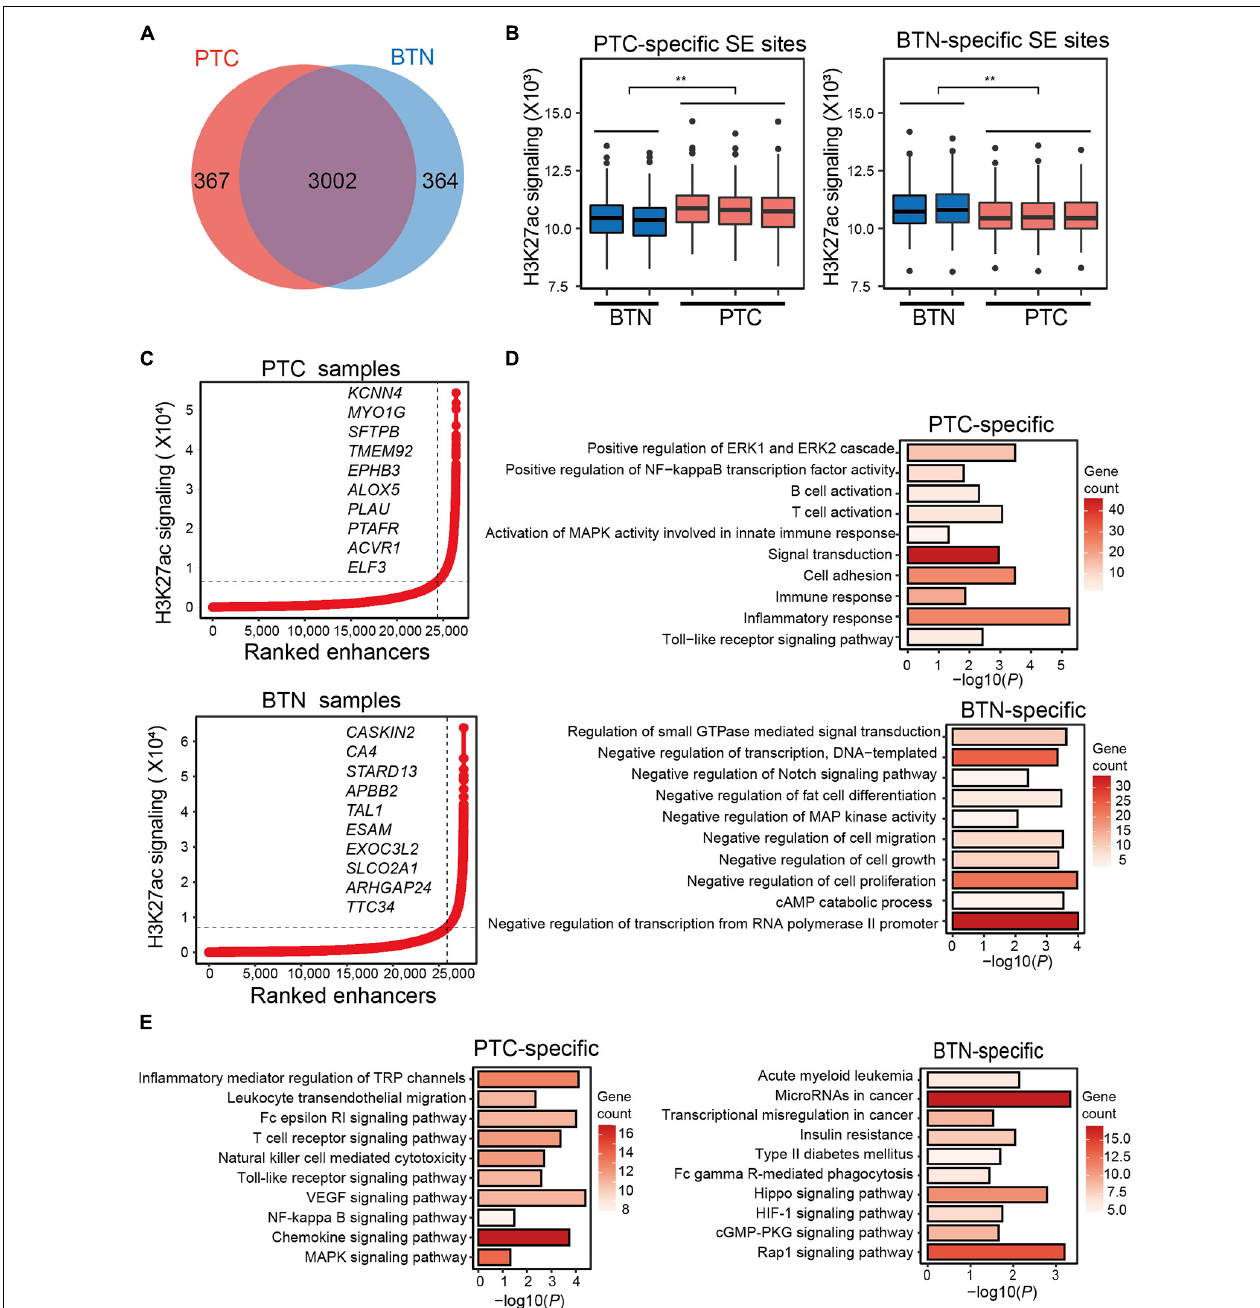
FIGURE 2 | Characterization of super-enhancers in PTC and BTN. (A) Venn diagram showing SE numbers of PTC-specific, BTN-specific, and overlapped SEs. (B) Histotype-specific genomic SEs showed significantly different H3K27ac signaling levels at PTC-specific or BTN-specific SE genomic sites. ** p < 0.01. (C) Enhancers of representative PTC and BTN sample were ranked by their H3K27ac signaling. Important genes were indicated by their ranks. (D) Bar plots showing GO terms of PTC- and BTN-specific SE-associated genes. (E) Bar plots showing KEGG pathway analysis in PTC and BTN. PTC, papillary thyroid carcinoma; BTN, benign thyroid nodule; SE, super-enhancer; GO, gene ontology; KEGG, Kyoto Encyclopedia of Genes and